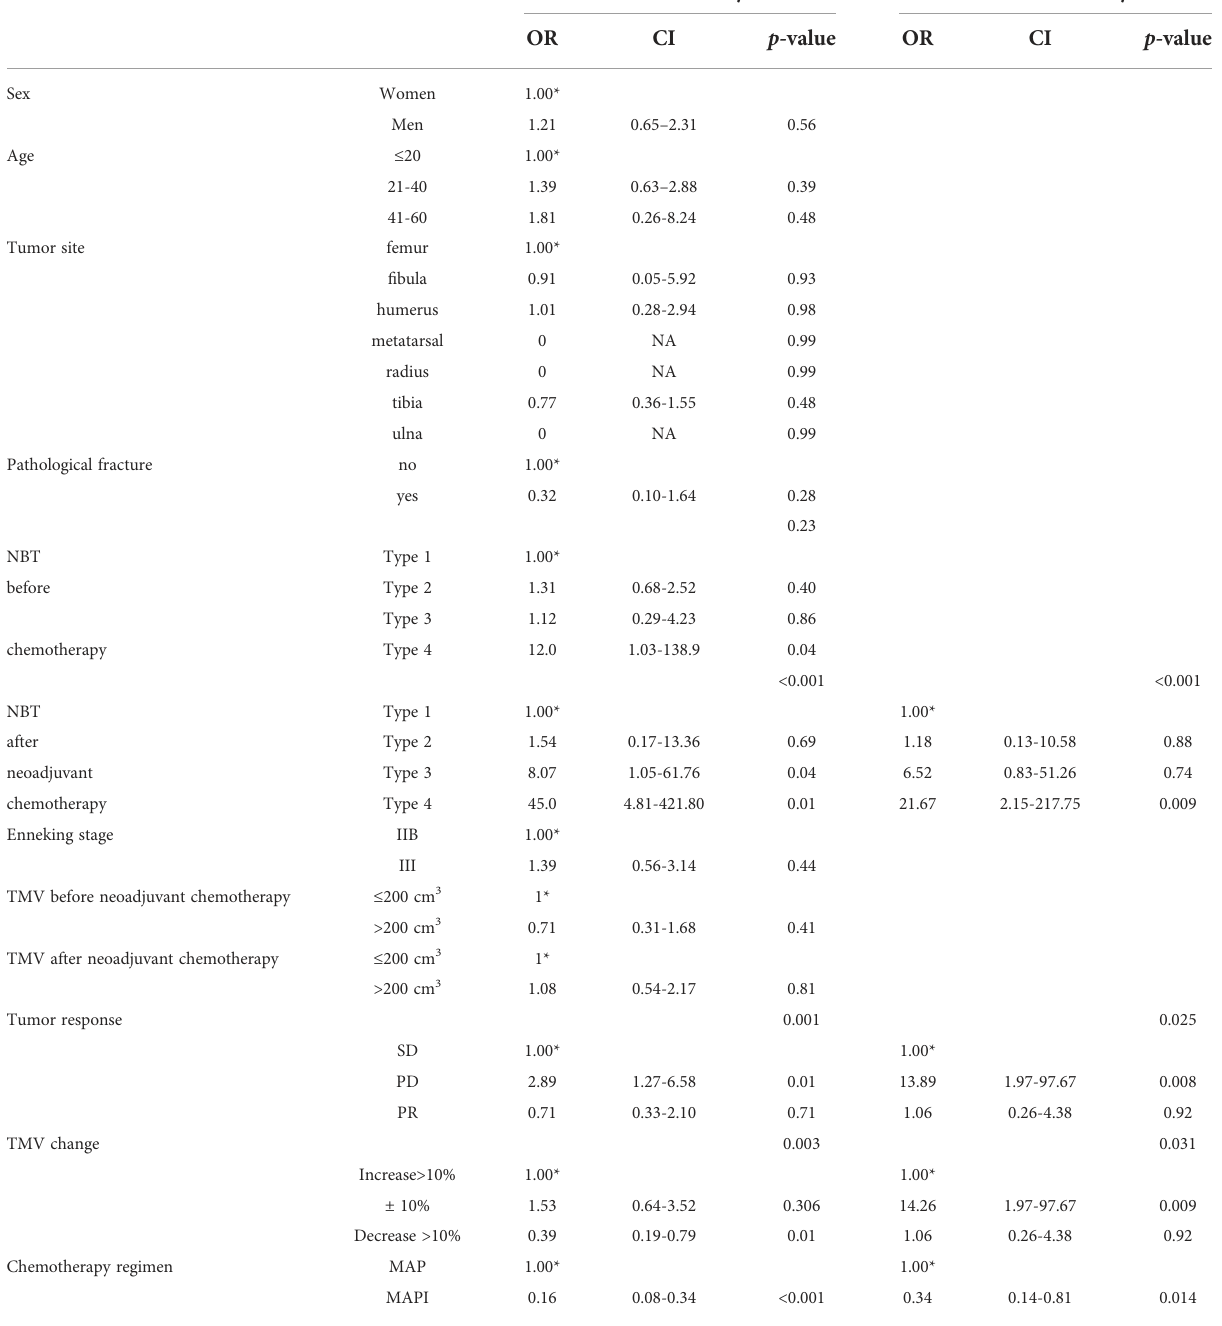
TABLE 3 Univariate and multivariate logistic regression model of predictors for receiving